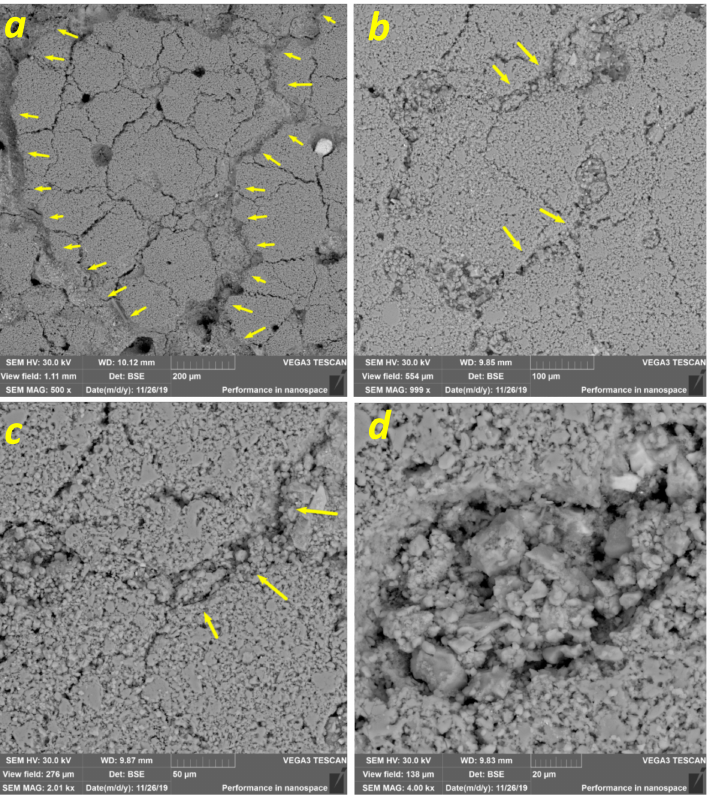
Figure 6. Ex situ SEM BSE images of primary compaction bands ( a ), accommodation compaction bands formed by fragment compaction in the interblock spaces ( b , c ), and former pores filled with small fragments as a result of microcracking ( d ) at 0.8 of ultimate compaction stress. The evolution of the distances between peaks may correspond to that of the block